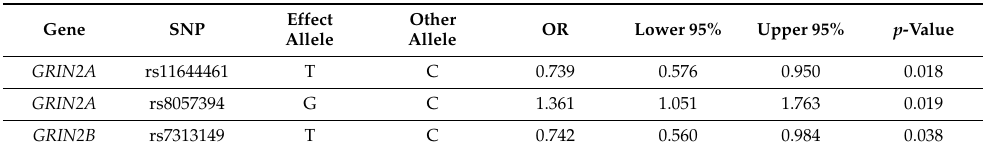
Table 2. Odds ratios calculated for polymorphisms of the studied genes associated with the type of course of schizophrenia.